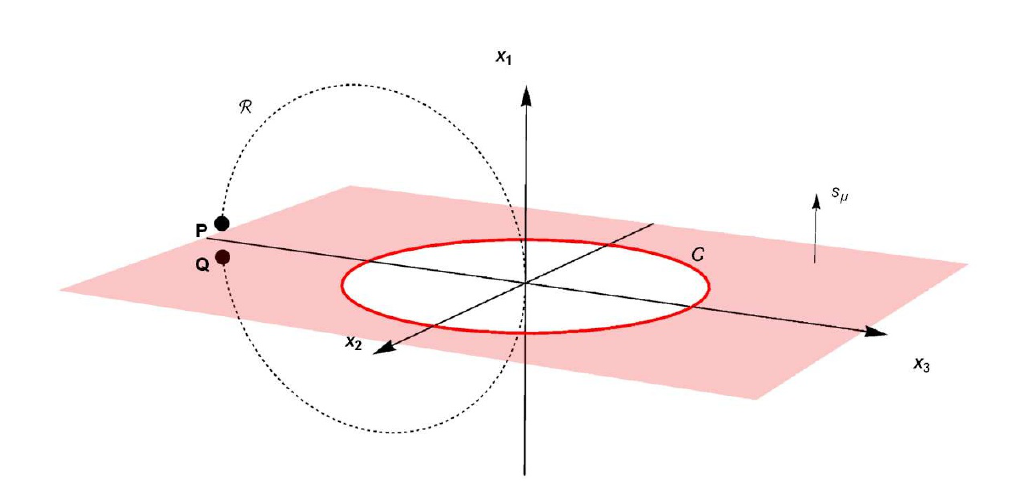
Figure 3 . A ring winding around the Wilson loop and passing through the origin. The surface R where s µ is concentrated is depicted in